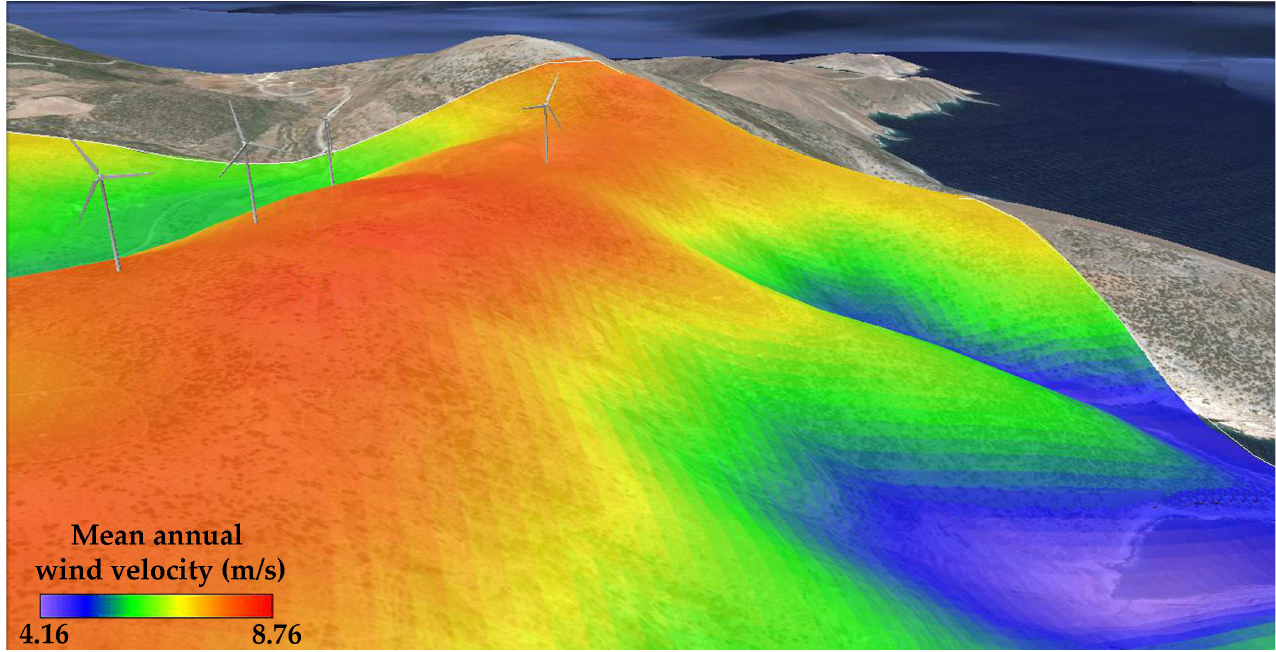
Figure 9. Siting of the wind park over a 3D annual average wind velocity